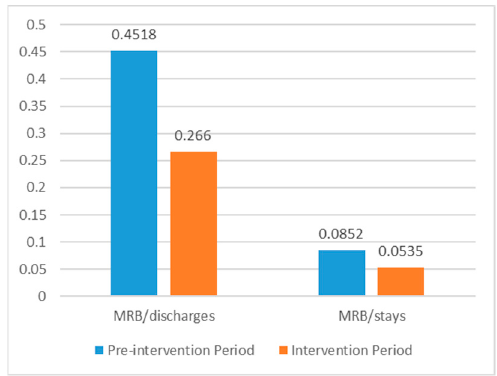
Figure 5. Comparison of the overall incidence of multiresistant bacteria per discharges and bed-days between the Pre-intervention period and the Intervention Period. MR: multiresistant bacteria.